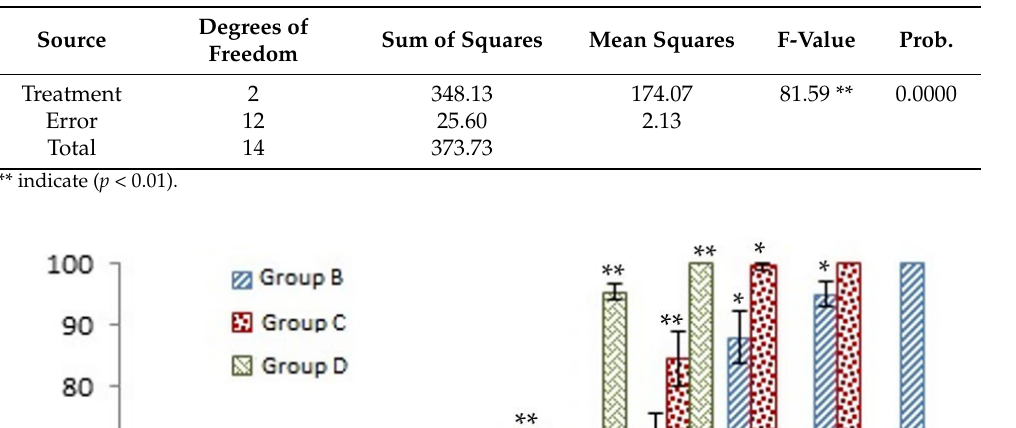
Table 8. Analysis of variance table for healing time (days). Source